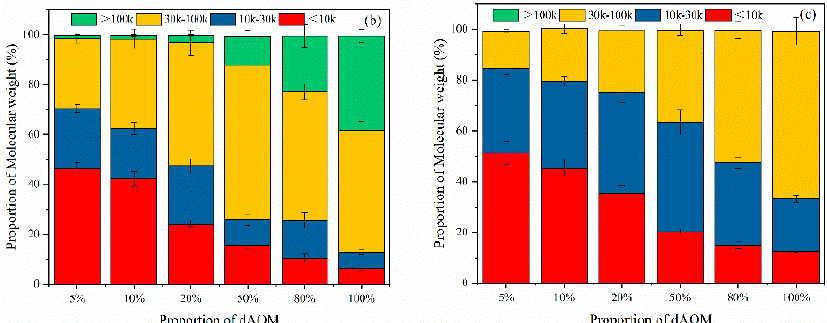
Figure 6. Change in molecular weight before and three hours after adding MC ( a ), change in molecular weight distribution before adding MC ( b ), change in molecular weight distribution three hours after adding MC ( c ).